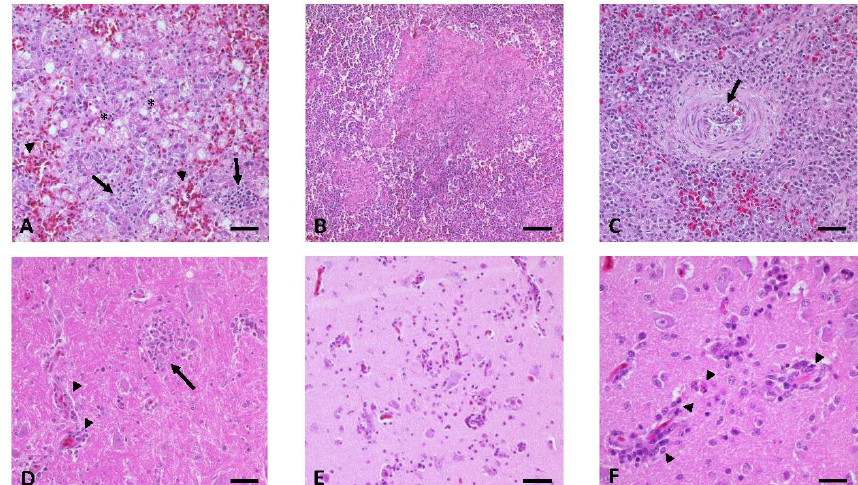
Figure 5. Histopathological findings in WNV-infected geese. ( A ) Liver of G 01, showing vacuolar degeneration (*), acute hemorrhages (arrowheads), and multifocal subacute non-suppurative hepatitis (arrows). (B,C) Variability of pathomorphological lesions in the spleen with ( B ) focal acute necrotizing splenitis of G 03 and ( C ) focal mild subacute non-suppurative arteritis with distinct intima hyperplasia (arrow) in the vessel wall of G 13. (D-F) Multifocal acute to subacute non-suppurative encephalitis ( D ) in the brain stem of G 02 with glia nodules (arrow) and mild lymphohistiocytic perivascular cuffing (arrowheads). ( E ) Cerebrum of G 06 with necrotic foci consisting of mild lymphoplasmacellular perivascular cuffing, migrating mononuclear cells, small glia nodules, and scattered single cell necrosis (neurons, glia cells, and leucocytes). ( F ) Cerebrum of G 06 with leucocytic degeneration (arrowheads) within the mononuclear perivascular cuffing (lymphocytes, histiocytes, and plasma cells). Bars: A–E 50 µm, F 20 µm.